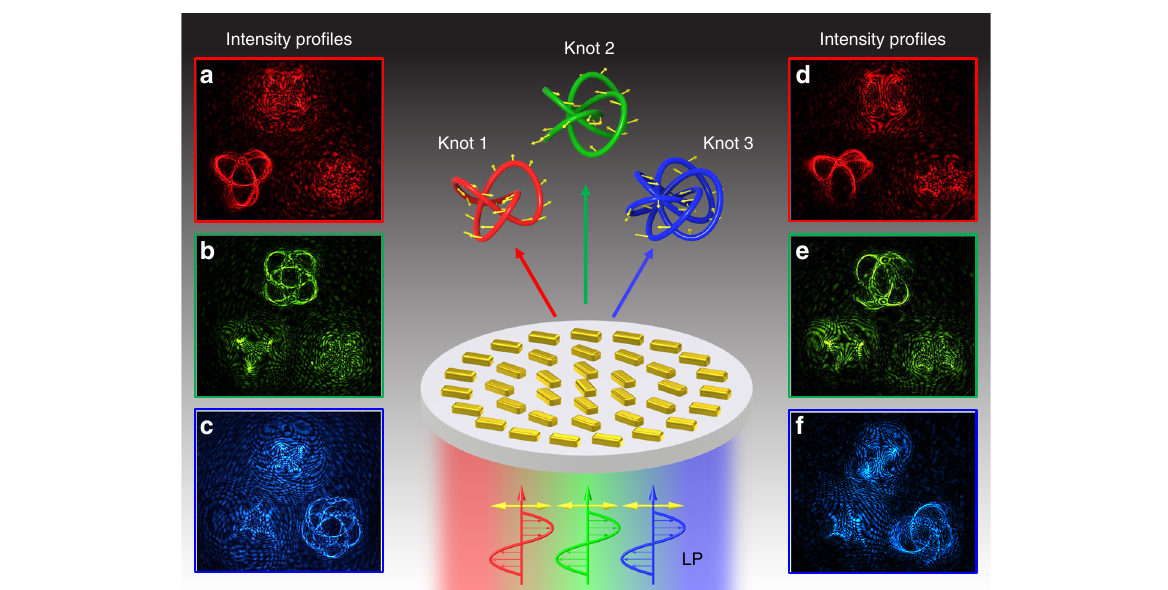
Fig. 1 Schematic of the metasurface device for generating color-selective 3D polarization structures. Here, a 3-foil knot (knot 1), a 4-foil knot (knot 2), and a 5-foil knot (knot 3) are selected as complex polarization structures. Knots 1, 2, and 3 are predesigned polarization structures in the same observation region for the wavelengths of 650, 575, and 500 nm, respectively. The polarization directions of points on the 3D knots are denoted with yellow arrows. Both polarization and color information (wavelength) of these three knots are encoded into a single metasurface consisting of gold nanorods. a – c The measured intensity pro fi les upon the illumination of a horizontal LP light beam before and d – f after passing through a polarizer (analyzer). a and d are generated at λ = 650 nm, b and e at λ = 575 nm, and c and f at λ = 500 nm in the same observation plane of z = 500 μ m. The intensity pro fi les d – f correspond to the analyzer with a transmission axis along the vertical